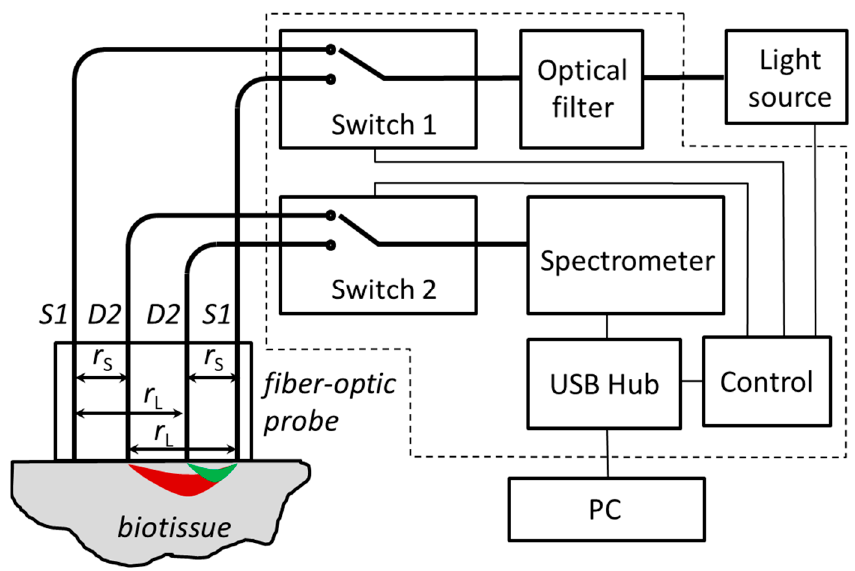
Figure 1. Schematic of experimental setup with self-calibrating fiber-optic probe. S1,2: the source fibers; D1,2: the detection fibers; areas of effective sensitivities for short ( r S ) and long ( r L ) SDDs are marked with green and red colors, respectively. Bold lines indicate optical fibers, thin lines indicate electrical connections. Elements within the dashed frame are placed in a single housing.